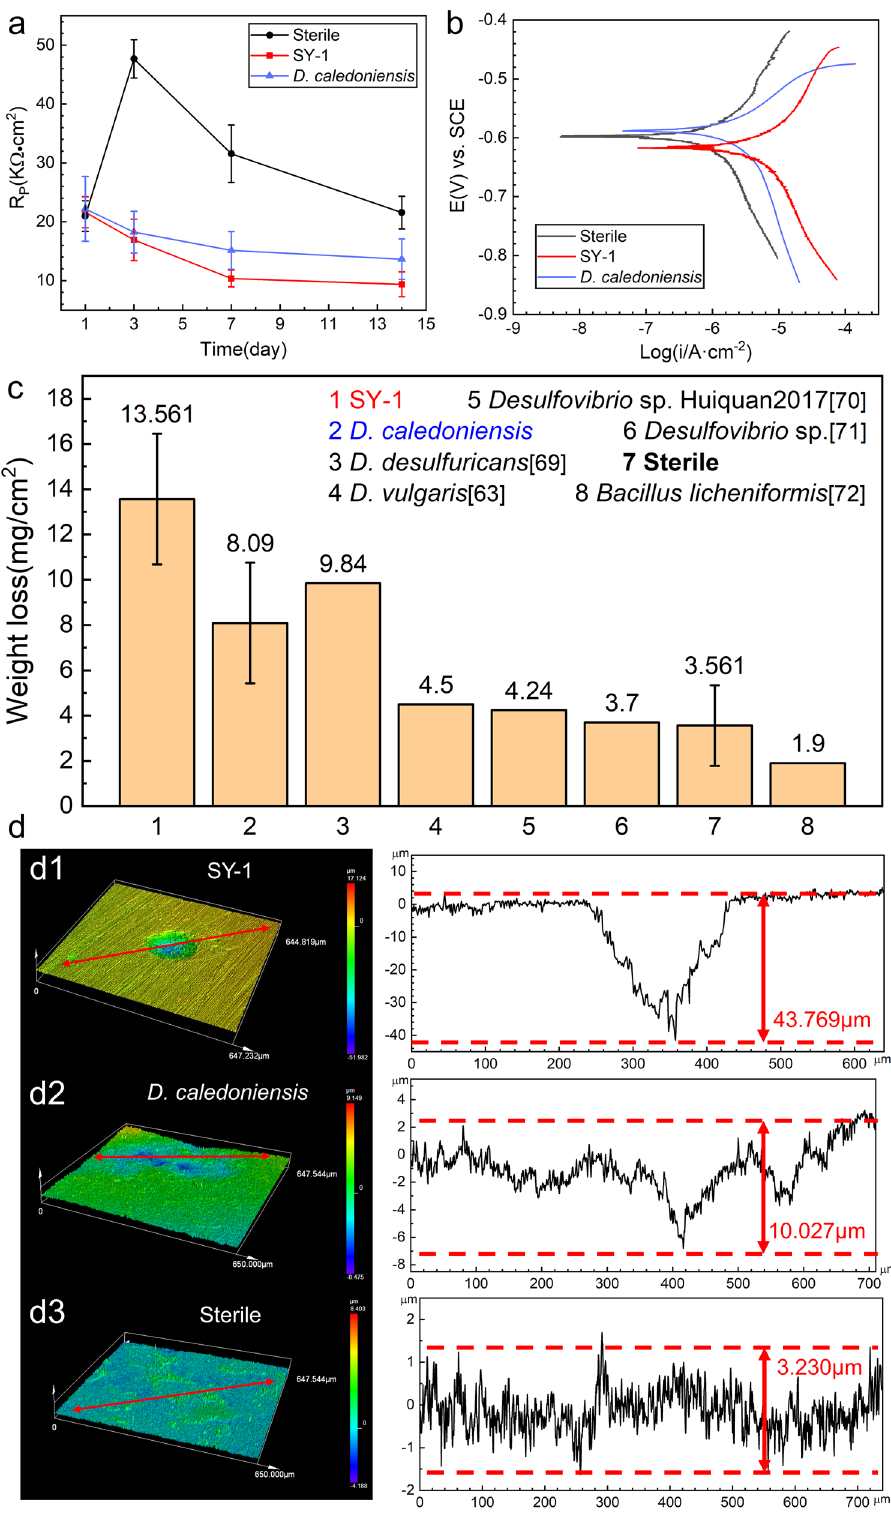
Fig. 8 Corrosion rate tests on D. bizertensis SY-1. a LPR, b potentiodynamic polarization curves, c weight loss, and d CLSM images of the Q235 coupons in the sterile, SY-1 strain, D. caledoniensis inoculated culture media after 15 days (error bars stand for the standard deviations from three independent